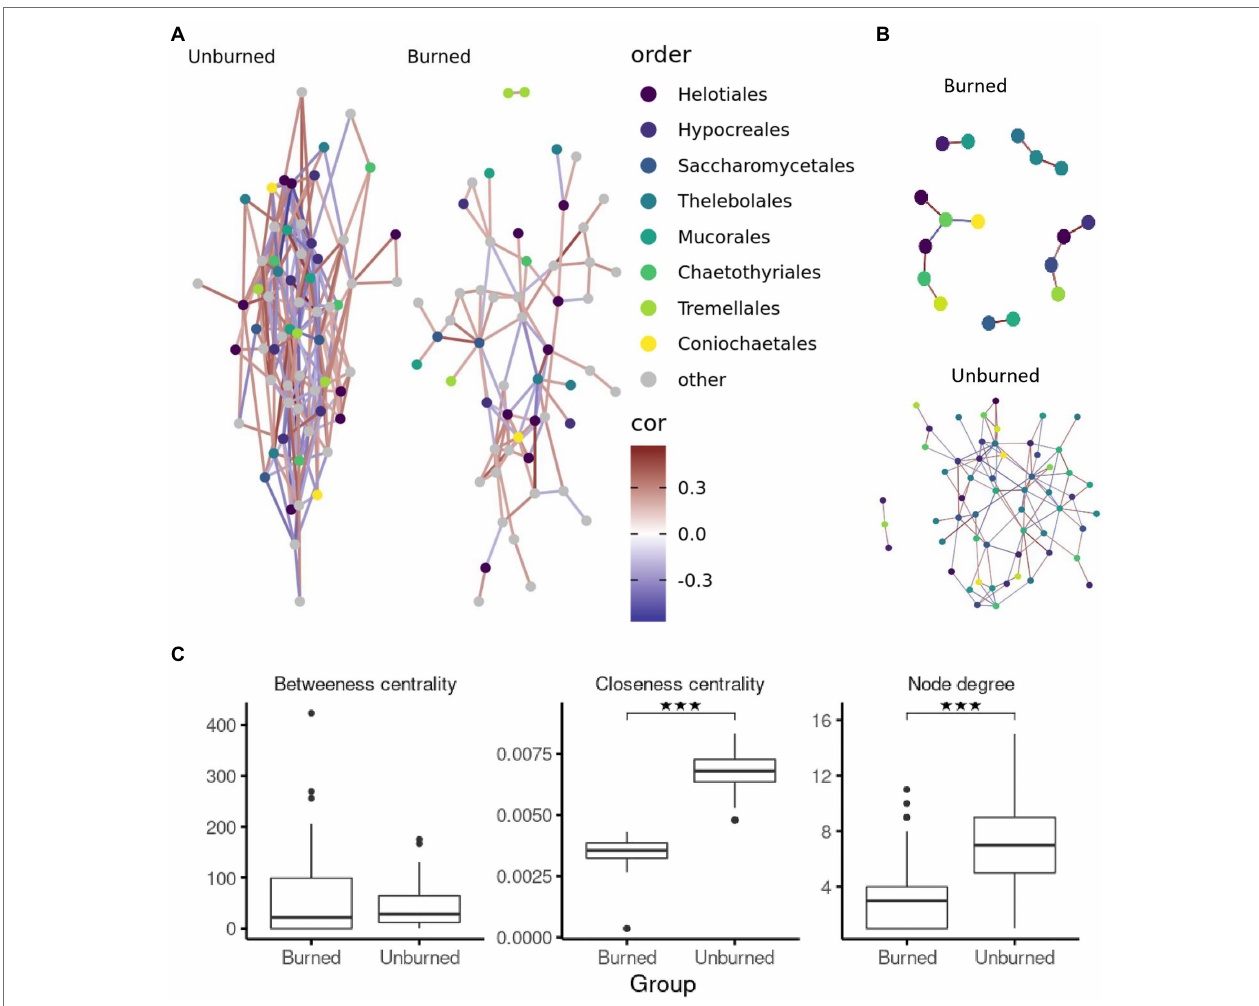
FIGURE 3 | Correlation networks of burned and unburned soil samples. SparCC correlation networks per sample group using (A) default threshold